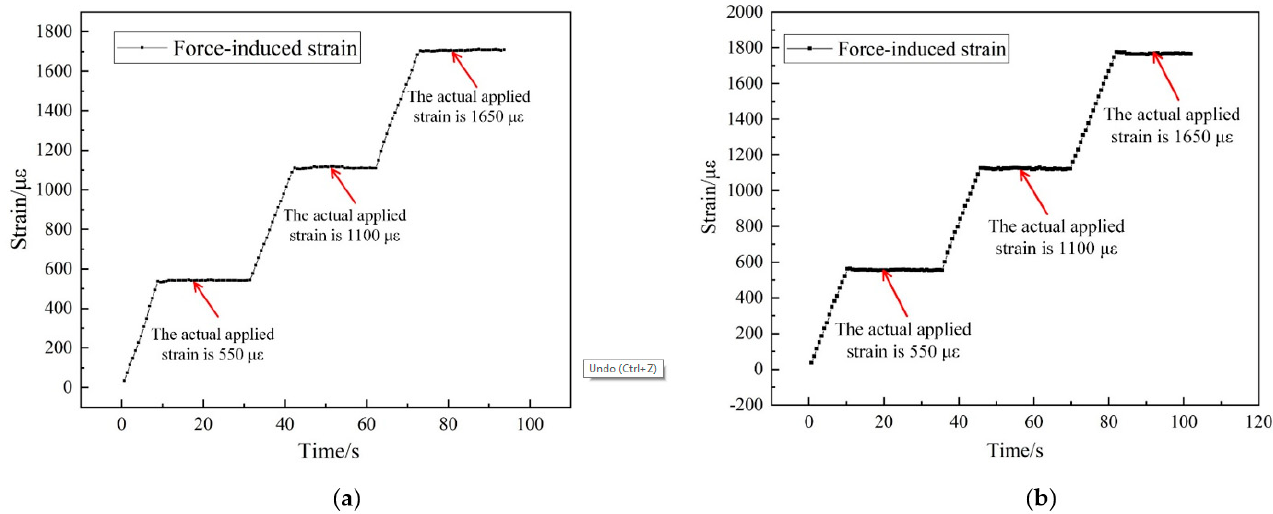
Figure 12. Results of high-temperature strain measurement with temperature compensation, ( a ) under 500 °C; ( b ) under 1000 °C.